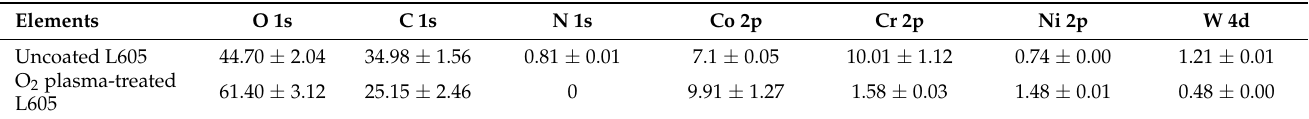
Table 1. XPS surface atomic percentages (at.%) of uncoated L605 before and after oxygen (O 2 ) plasma treatment, n = 3.